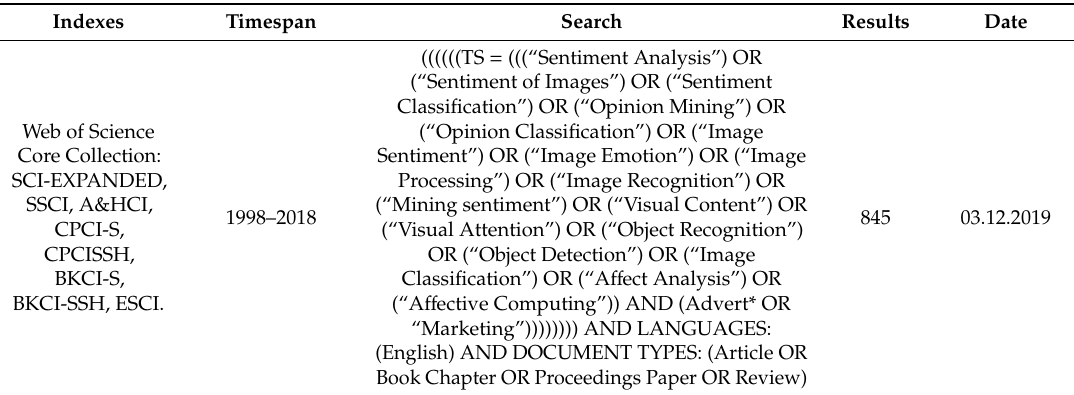
Table 6. Details of